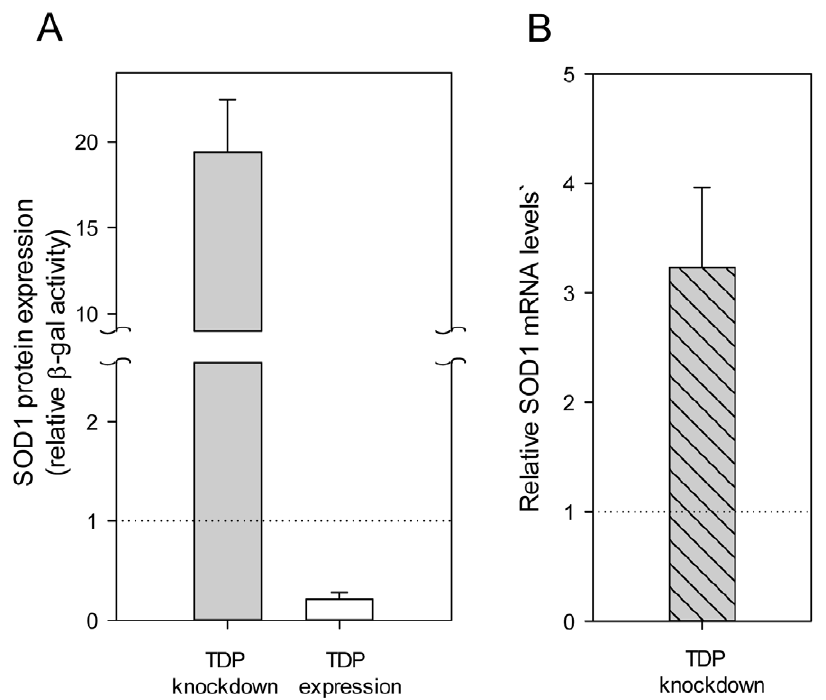
Figure 5. Regulation of SOD1 levels by TDP-43. A ) TDP-43 knockdown or over expression was carried out in HeLa TetOn cells expressing the A4V reporter plasmids. Supernatant fractions were assayed for b -gal activity. Soluble SOD1 reporter expression levels ( b -gal activity) relative to controls (dotted line) are shown. Sample sizes ranged from 8 to 23. The error bars represent 95% confidence interval. B ) Quantitative PCR analysis of SOD1 reporter mRNA levels was carried out on total mRNA isolated from cells transfected with control or TDP-43 siRNA and A4VSOD1 reporter plasmids. The SOD1 mRNA levels of TDP siRNA treated samples are shown relative to control (dotted line). The error bars represent 95% confidence